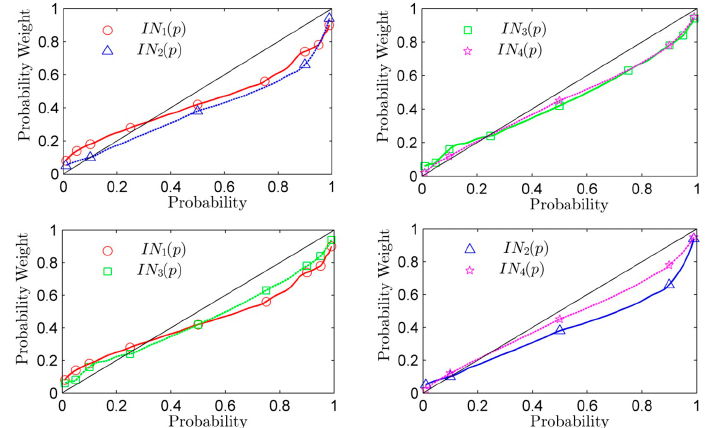
Figure 9. Curves of nonparametric numerical models based on aggregate experimental data. IN 1 ( p ) and IN 2 ( p ), respectively, correspond to event outcomes 0 < e < 200 and e ≥ 200, both represent decision-maker’s PWF for positive prospects. N 3 ( p ) and N 4 ( p ), respectively, correspond to event outcomes –200 < e < 0 and e < –200, both show decision-maker’s PWF for negative